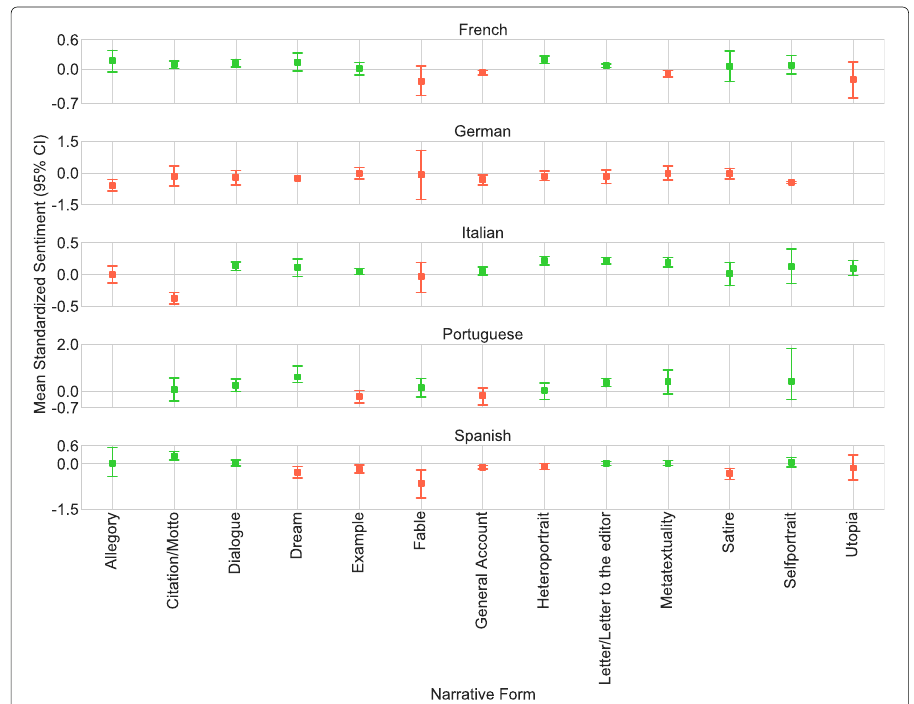
Fig. 3 Mean Standardized Sentiment For Narrative Forms. This figure illustrates the mean standardized sentiment (with 95% bootstrap confidence intervals) for each narrative form, respectively for each language contained in our dataset. Red squares indicate a more negative sentiment and green squares indicate a more positive sentiment compared to the language mean. Note that not all text passages follow a specific narrative form and that German and Portuguese do not include all narrative forms. We observe significant differences across